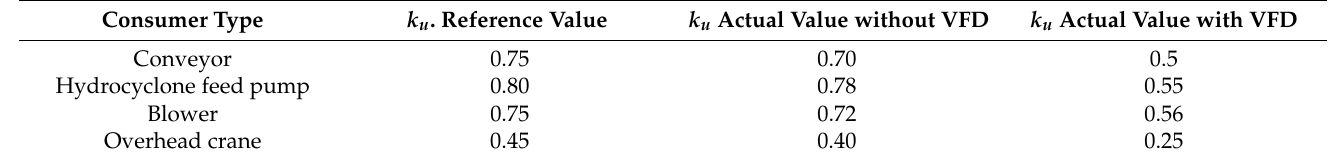
Table 3. Utilization